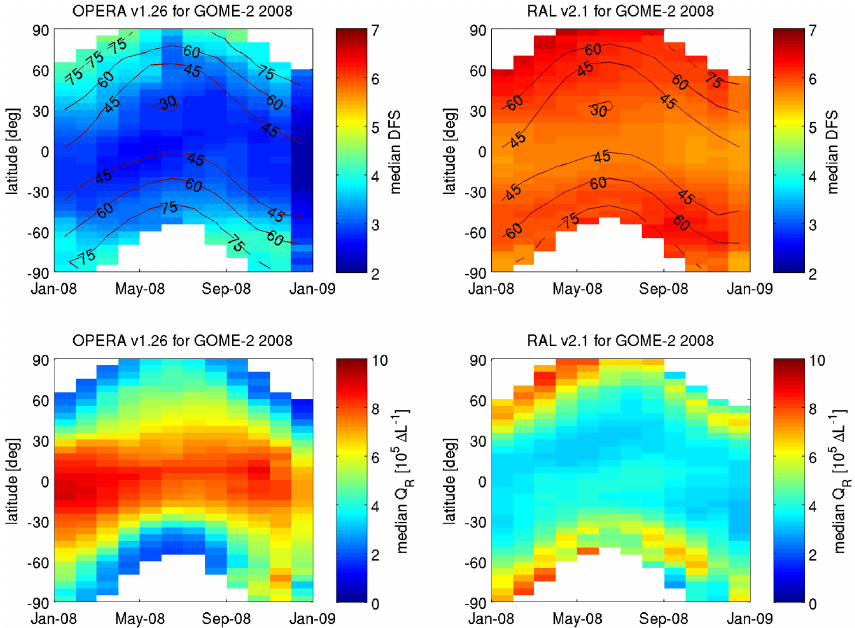
Figure 4. Latitude-time cross-section (5 ◦ latitude bands, monthly) of median information content measures applied to OPERA and RAL fractional averaging kernel matrices: DFS (upper line) and Q R (lower line). Solar zenith angle contour plots (values in degrees) have been added to the DFS graphs. The layer thickness metric (cid:49)L is calculated as log(pressure)